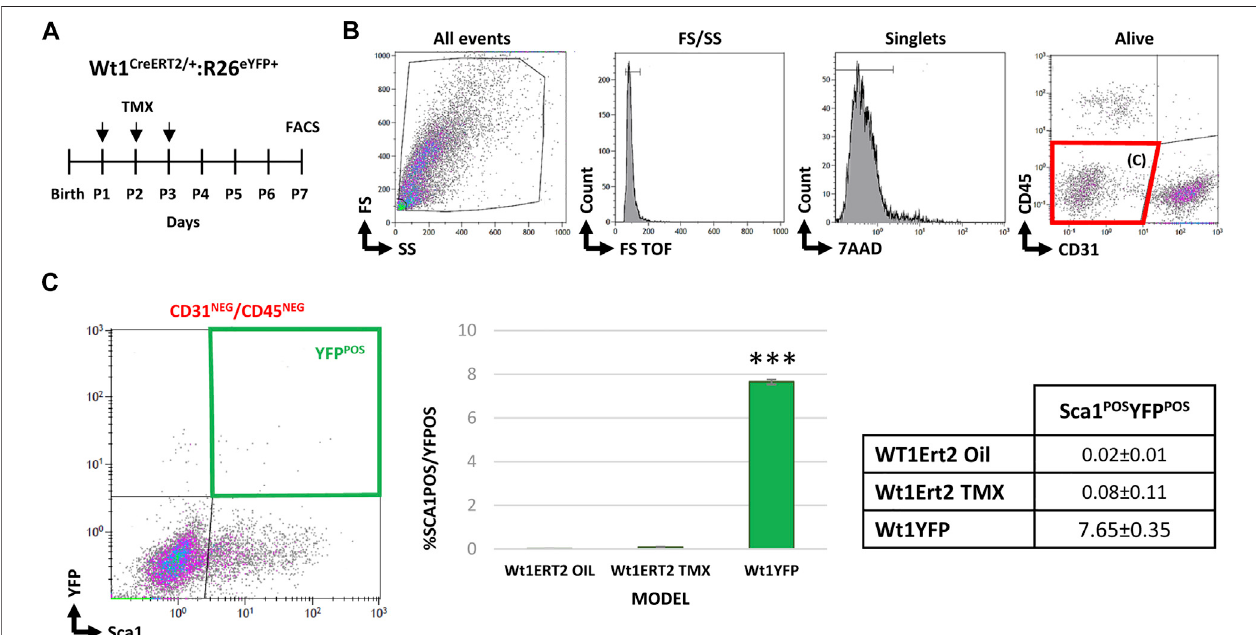
FIGURE 5 | Studying de novo cardiac expression of Wt1 after birth. (A) Wt1Cre-ERT2 mice were crossed with the Rosa26R-eYFP reporter line to conditionally induce the activation of the driver between P1 and P3. (B) Representative dot blots and cytograms showing the gating strategy followed to characterize CD31 NEG / CD45 NEG cardiac interstitialsubpopulations. (C) Barplotrepresentationofcardiac CD31 NEG /CD45 NEG /Sca1 POS /YFP POS cellsindifferentexperimentalgroups:Wt1Cre/ ERT2-YFPinjectedwiththevehicle(negativecontrol);Wt1Cre/ERT2-YFPinjectedwithtamoxifenasanexperimental group;andWt1Cre-YFP(positivecontrol)( n = 12 peer group). The table shows the percentages of each subpopulation. Abbreviations: CD31/PECAM1, platelet, and endothelial cell adhesion molecule 1; CD45, protein tyrosine phosphatase receptor type; FS, forward scatter; Sca1, stem cell antigen-1; SS, side scatter; YFP, yellow fl uorescent protein. *** p value ≤ 0.005.